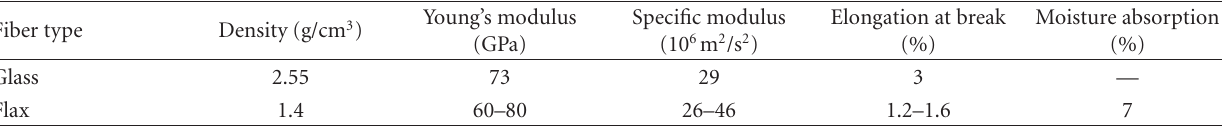
Table 1: Comparative mechanical properties of glass and flax fibers [23].